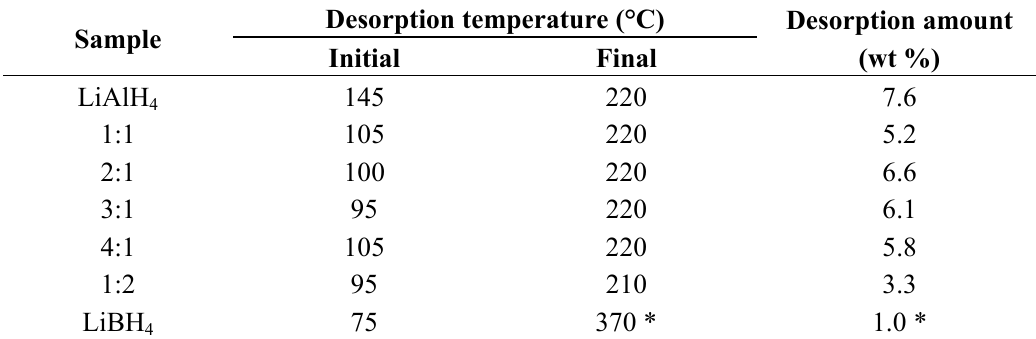
Table 1. Hydrogen desorption temperature and amounts of desorbed hydrogen of –LiBH LiAlH 4 4